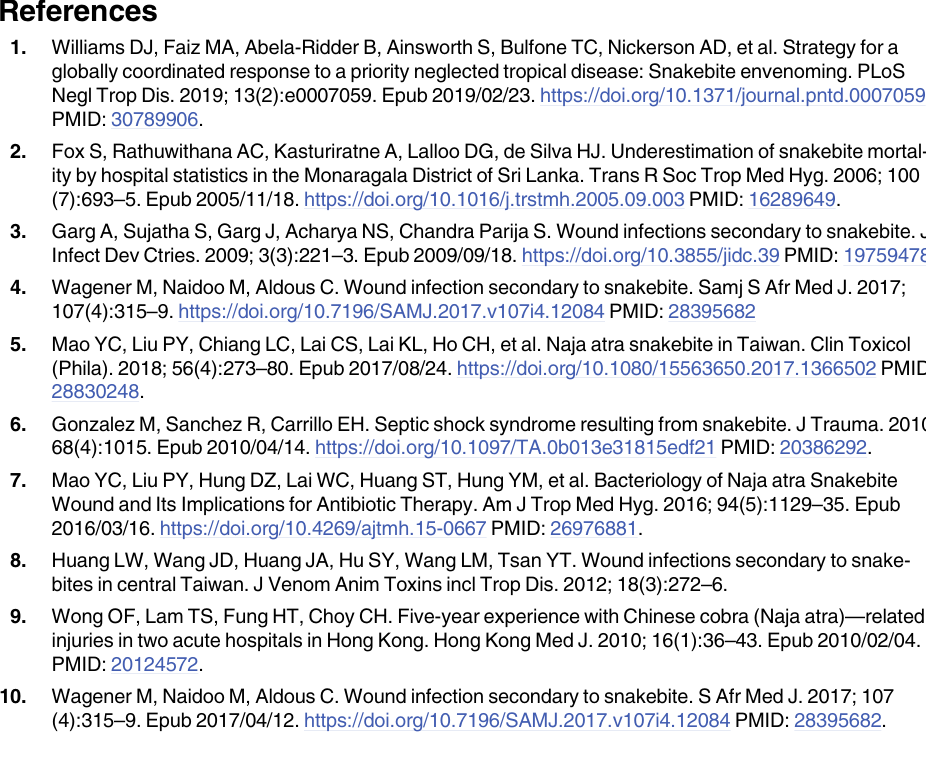
S1 Table. Bacteria identified by Sanger sequencing of 16S ribosomal RNA gene